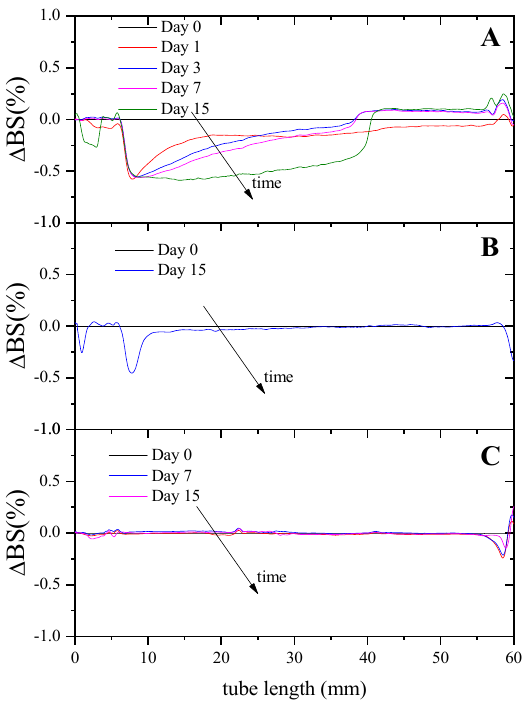
Figure 6. Backscattering profiles of W 1 /O/W 2 multiple emulsions obtained at two different xanthan gum (XG) concentrations: 0 ( A ), 0.125 ( B ) and 0.25 ( C ) wt.%.